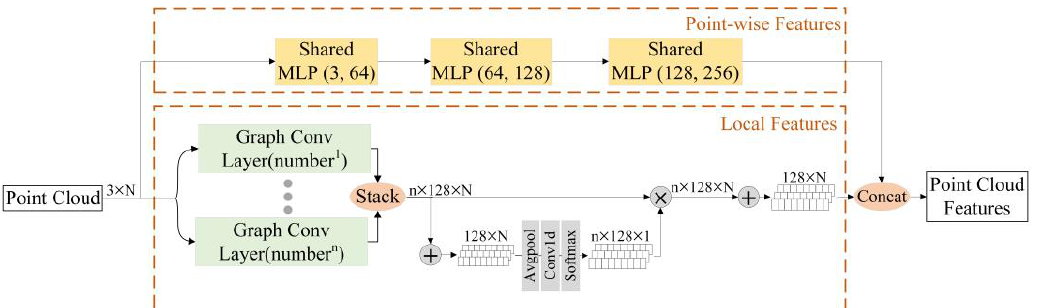
Figure 3. Structure of the multi-scale point cloud feature extraction network (MSPNet). The network can be divided into two parts, the upper part is the point-level feature extraction branch, while the lower part is the local feature extraction branch. The output features of the two branches are spliced as the geometric features of the point cloud. MLP is the abbreviation for multi-layer perceptron, and the numbers in brackets indicate the size of the layers.